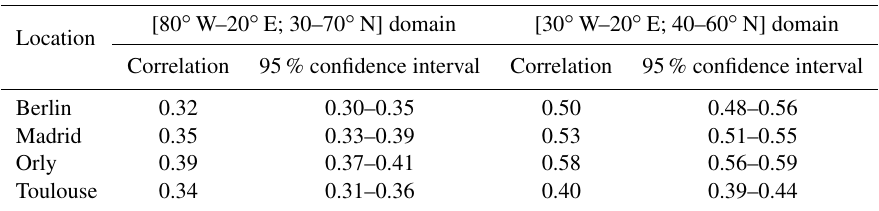
Table 1. Correlation between observations and the median of 100 simulations for the winter (DJF) for the different studied domains rep- resented in Fig. 1b, with the coordinates [80 ◦ W–20 ◦ E; 30–70 ◦ N] for the largest one (blue) and [30 ◦ W–20 ◦ E; 40 ◦ –60 ◦ N] for the red rectangle for a lead time of 5d.